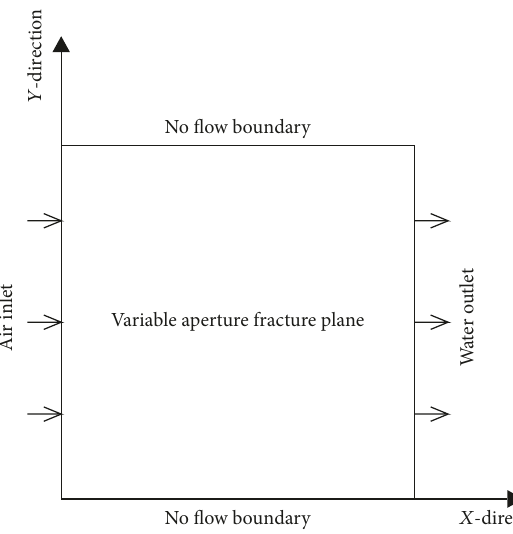
Figure 6: Boundary condition of air-water displacement simula-